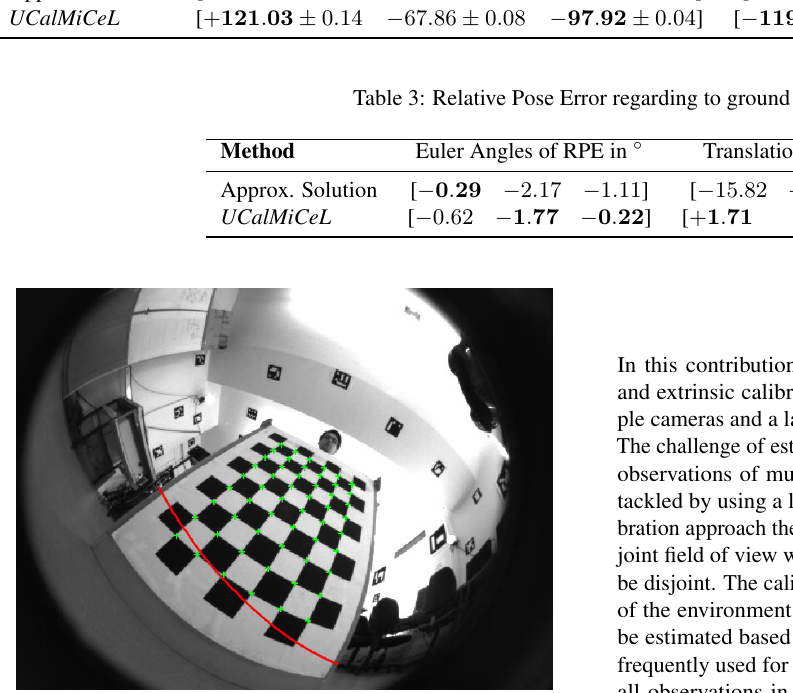
Figure 4: Laserscanner segment backprojected to the image. Green plus markers represent the extracted interest points used for estimation of the plane pose. Red dotted markers represent the correspondent laserscanner points. Obviously, in the data used for calibration, the correspondent observations are a good match. approximate solution. The final calibration result deviates a few millimeters from the ground truth